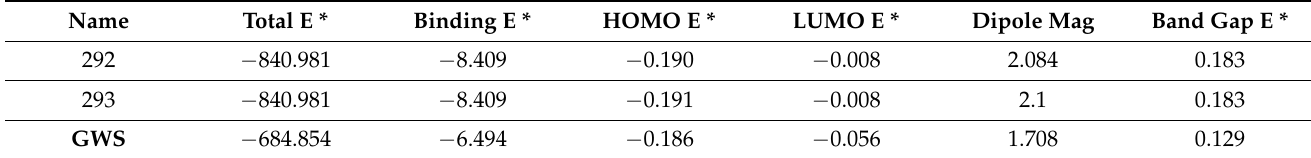
Table 5. Thermodynamic parameters of metabolites 292 , 293 , and GWS .